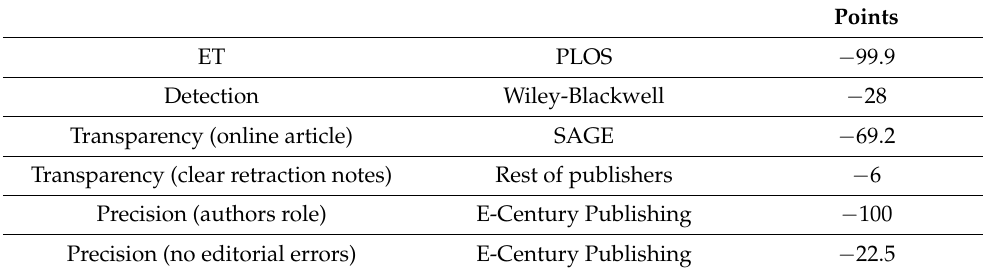
Table 28. Worst SDTP score performances